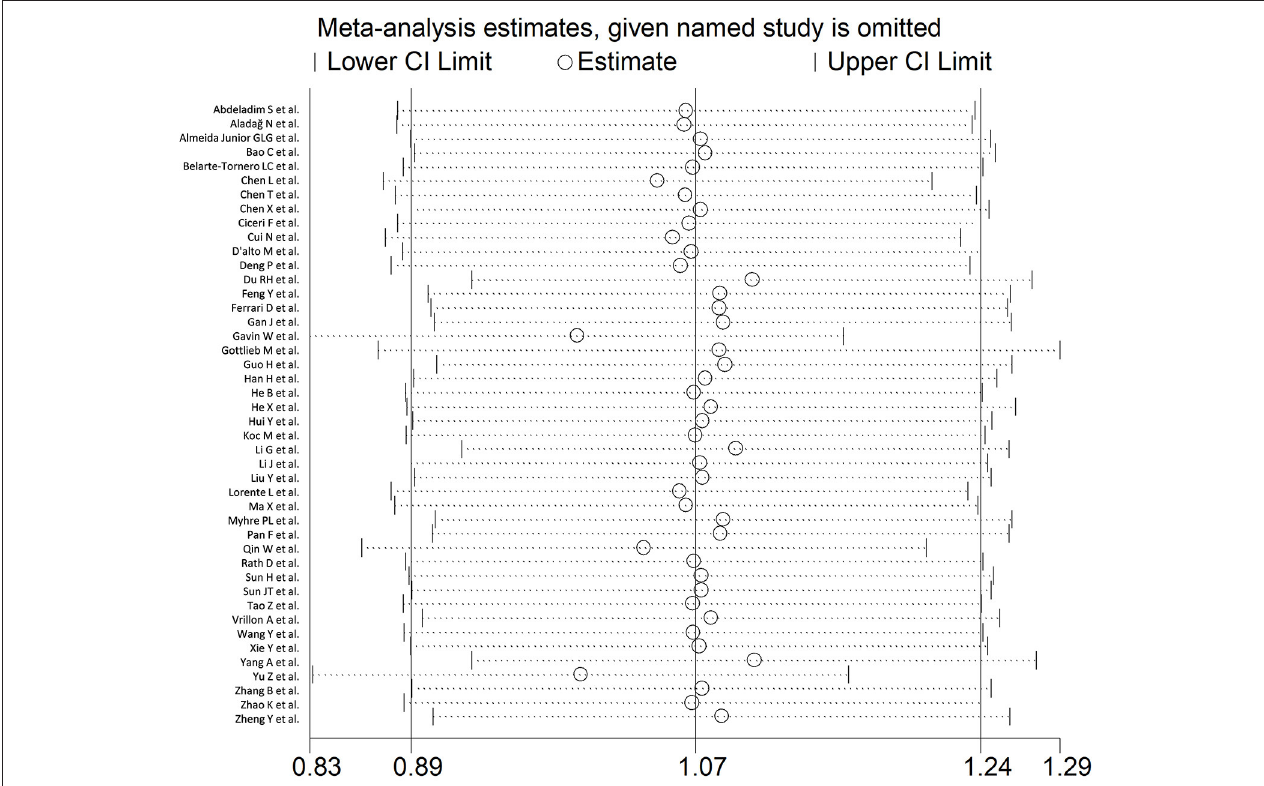
FIGURE 3 | Sensitivity analysis of the association between BNP and COVID-19 disease, assessed by investigating the influence of individual studies on the overall standardized mean difference (SMD). The SMD and the 95% confidence intervals (CIs) are indicated by the middle and the lateral vertical axes, respectively. The pooled SMD and the 95% CIs are indicated by the hollow circles and the two ends of each broken line, respectively.